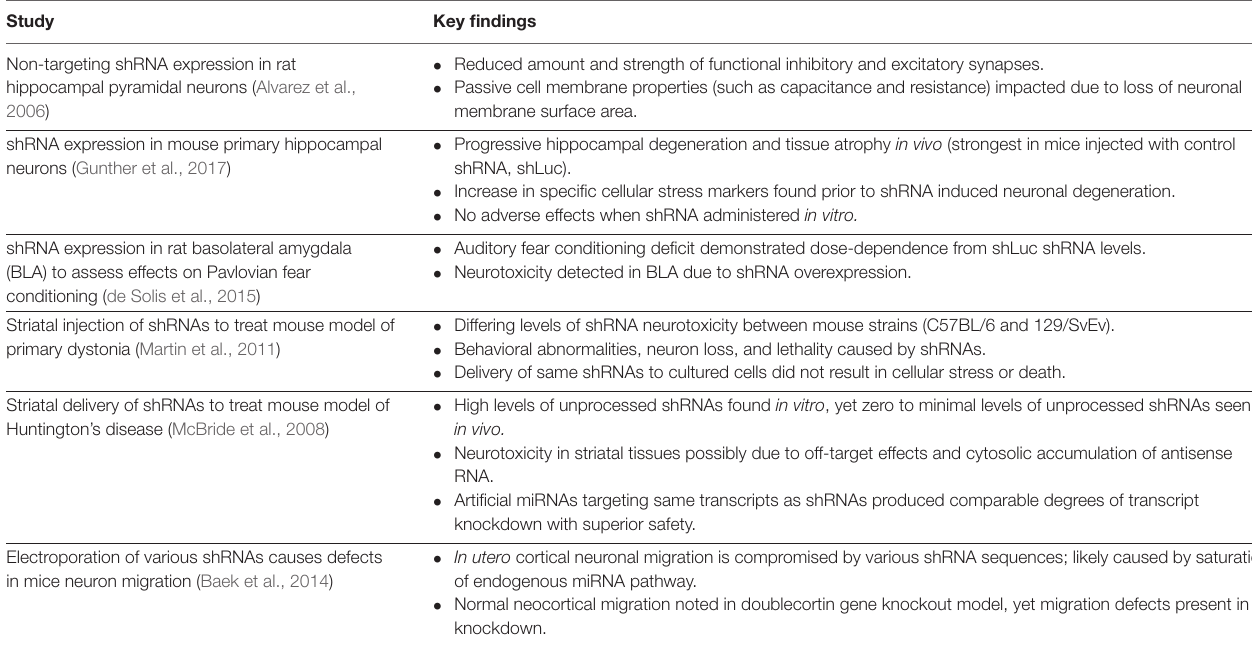
TABLE 1 | Studies of shRNA delivery in various models and their respective observations. Study Key findings • Reduced amount and strength of functional inhibitory and excitatory synapses. Non-targeting shRNA expression in rat • Passive cell membrane properties (such as capacitance and resistance) impacted due to loss of neuronal hippocampal pyramidal neurons (Alvarez et al., 2006) membrane surface